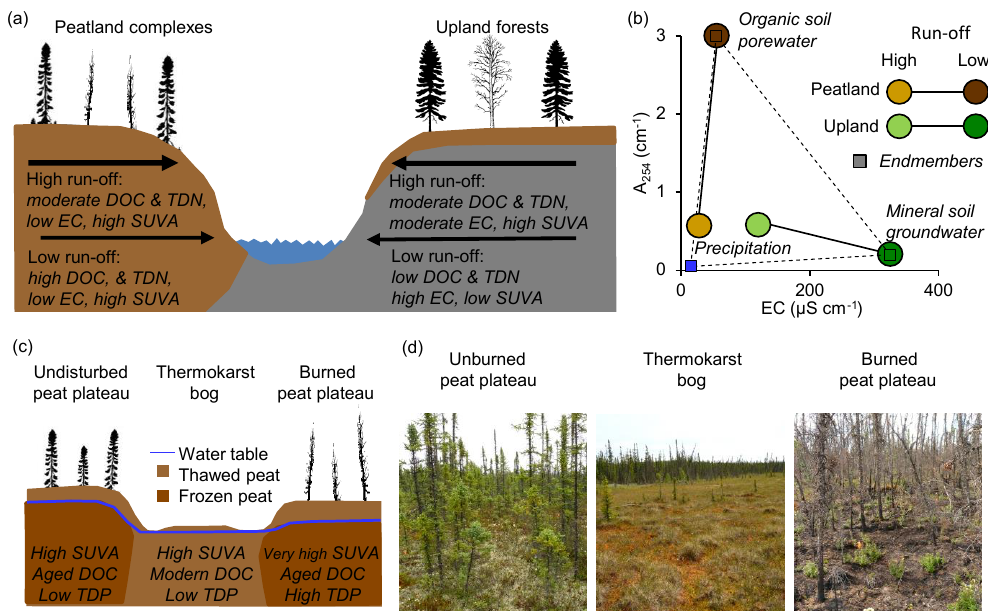
Figure 9. Conceptual controls on seasonal variation in stream chemistry for heterogeneous catchments with mixed peatland and upland forest land cover on the Taiga Plains of western Canada. (a) General water characteristics of run-off from peatlands and upland forests during low- and high-run-off generation, respectively. (b) Water chemistry of peatland and upland forest run-off during high and low-run-off periods, as conceptualized as a mixing of three endmembers: organic soil porewater, precipitation-like water, and mineral soil groundwater. Dotted line indicates the mixing space of endmembers. (c) Differences in DOC and nutrient characteristics among thermokarst bogs, undisturbed peat plateaus, and burned peat plateaus. (d) Representative photos of the three peatland